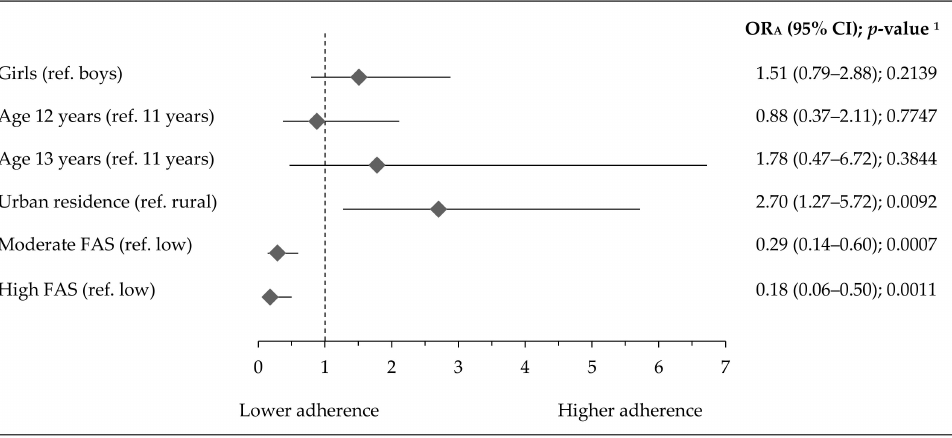
Figure 5. Factors associated with highST-lowPA pattern in Polish teenagers (ref. lowST-highPA pattern).